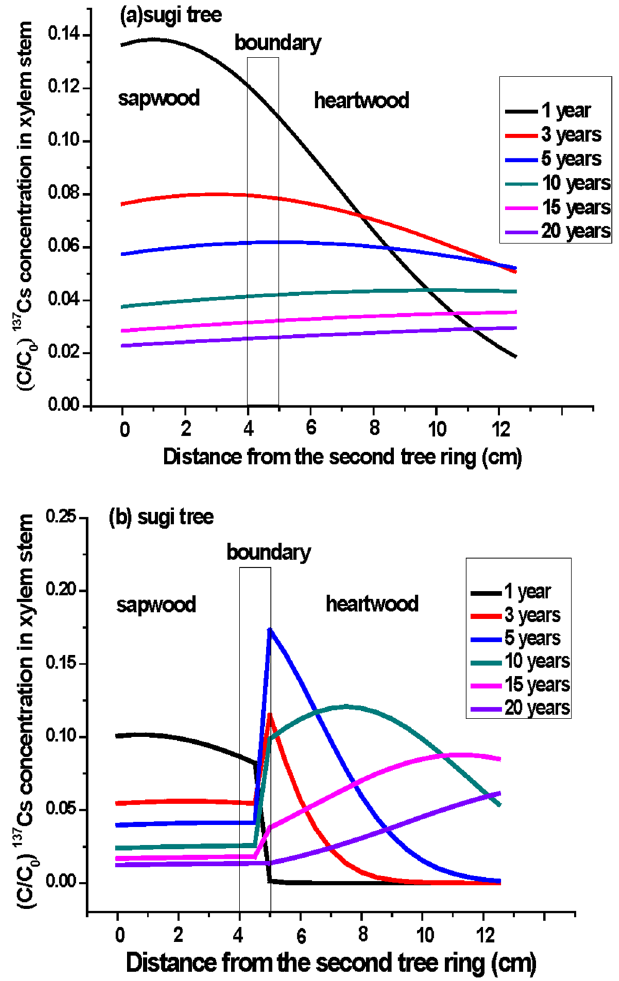
Figure 6. Distribution of the 137 Cs concentration ratio (C/C 0 ) in the xylem stem of a sugi tree estimated by using the simple one-dimensional advective diffusion transport model 37 . ( a ) Constant magnitude of diffusion coefficients of 137 Cs [1.66E−3 m 2 year −1 (= 5.26 × 10 –11 m 2 s −1 )], and ( b ) magnitude of diffusion coefficients changed in the intermediate wood zone (change from 1.66E−3 m 2 year −1 to 7.76E−5 m 2 year −1 (= 2.46 × 10 –12 m 2 s −1 ) after 0.045 m). Note: The 137 Cs migration velocity is 0.0075 m year −1 in xylem stems. The radioactivity was corrected by using the radioactive decay constant λ = 0.023 year −1 . x = 0 is the top of the second tree ring removed the outer and inner bark, phloem, cambium, and the first tree